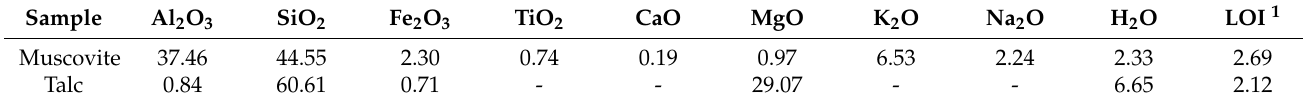
Table 1. Chemical composition of mineral samples (mass fraction, %).